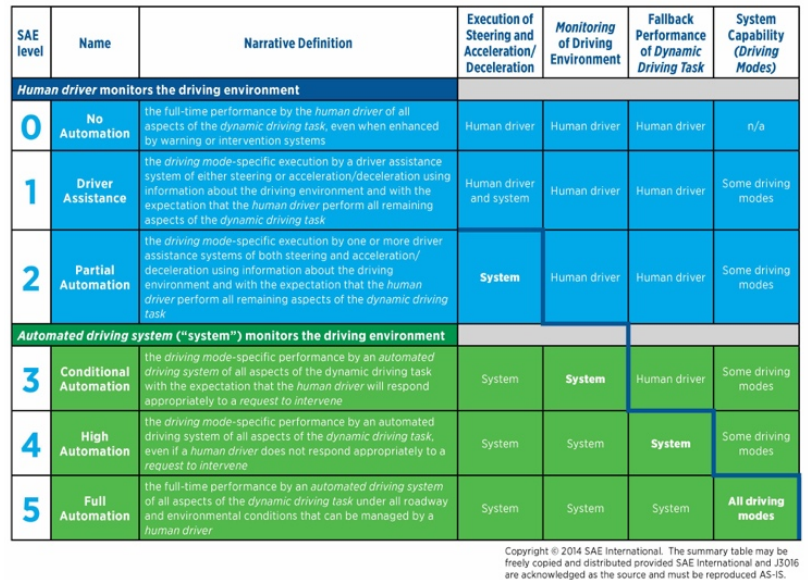
Figure 12. Levels of automation. Reproduced with permission from SAE, USA 2014.